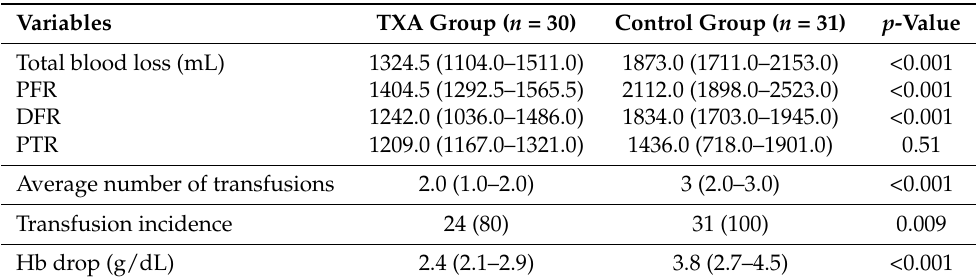
Table 2. Blood loss parameters for the two study groups.